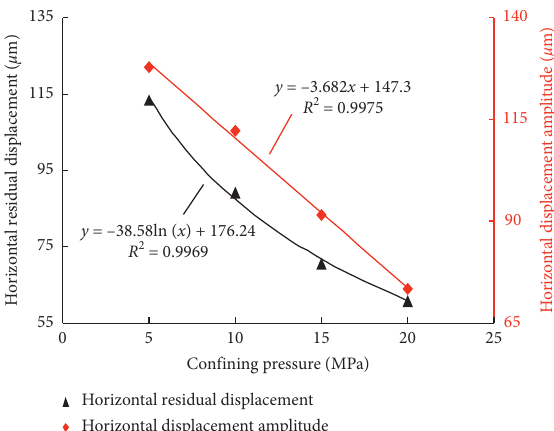
Figure 10: Horizontal displacement of the working block and time history curve under different confining pressures. Figure 11: Relation curve between the confining pressure and the horizontal residual displacement and displacement amplitude of the working block.